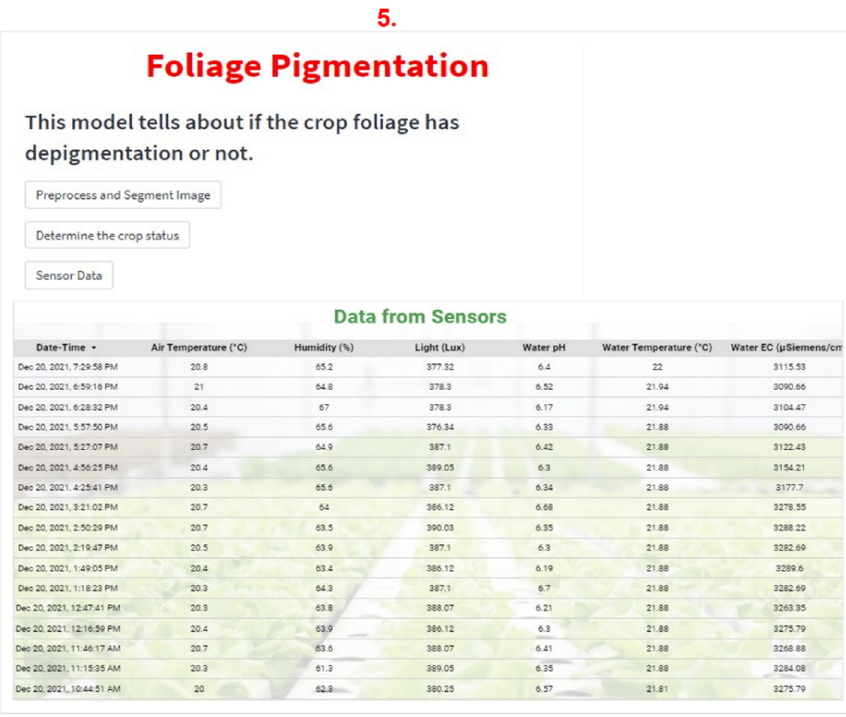
Figure A1. Stages 1 and 2 of cloud-based application.